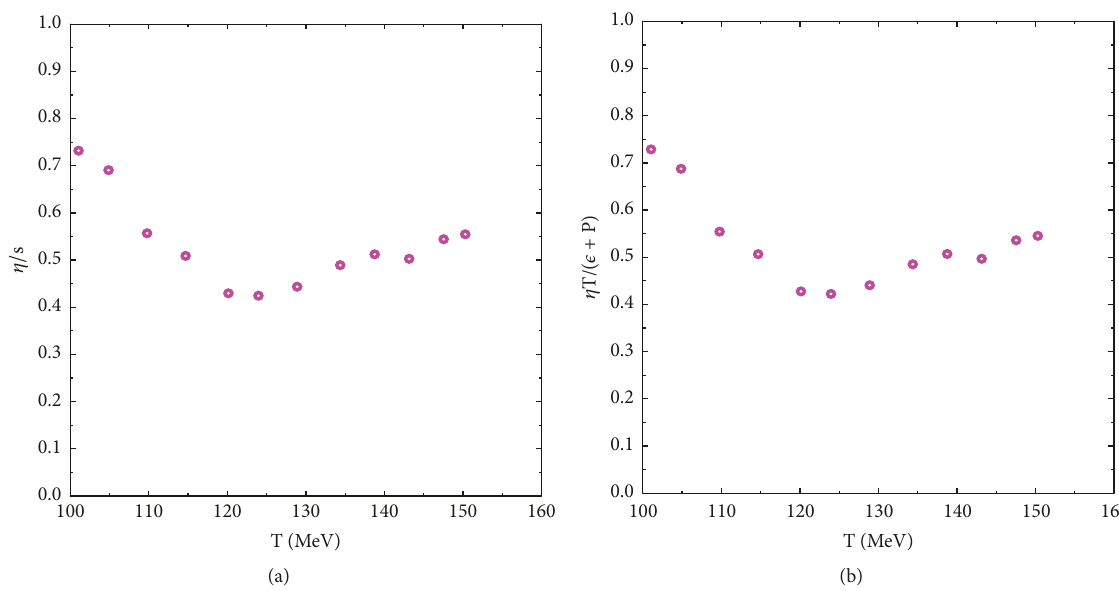
Figure 6: Fluidity measures along the chemical freeze-out line ((26) and (27)). The freeze-out curve parametrization is taken from [47].